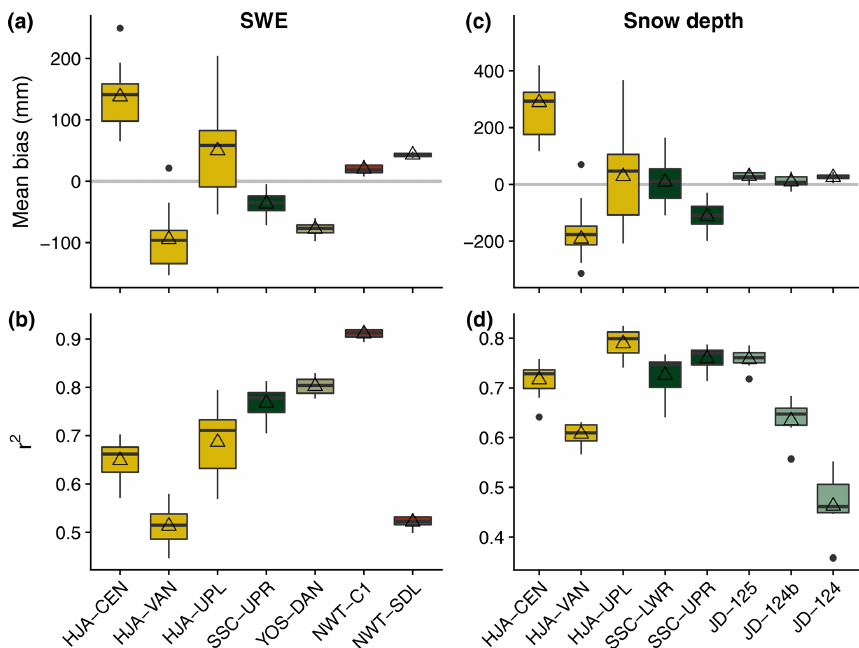
Figure 4. Mean bias (a, c) and r 2 (b, d) values for the SNOWPACK simulations relative to observed SWE (a, b) and snow depth (c, d) . The boxplots show the median, interquartile range, minimum, maximum, and outlying values for each objective function for the different precipitation phase methods at a given station. The open triangles indicate the mean objective function value for all precipitation phase methods at that station. Note: in panel (c) the low mean biases for JD snow depth are due to small snow depth values at the site. Mean relative biases at these stations were 35.4% (JD-125), 3.8% (JD-124b), and 35.7%